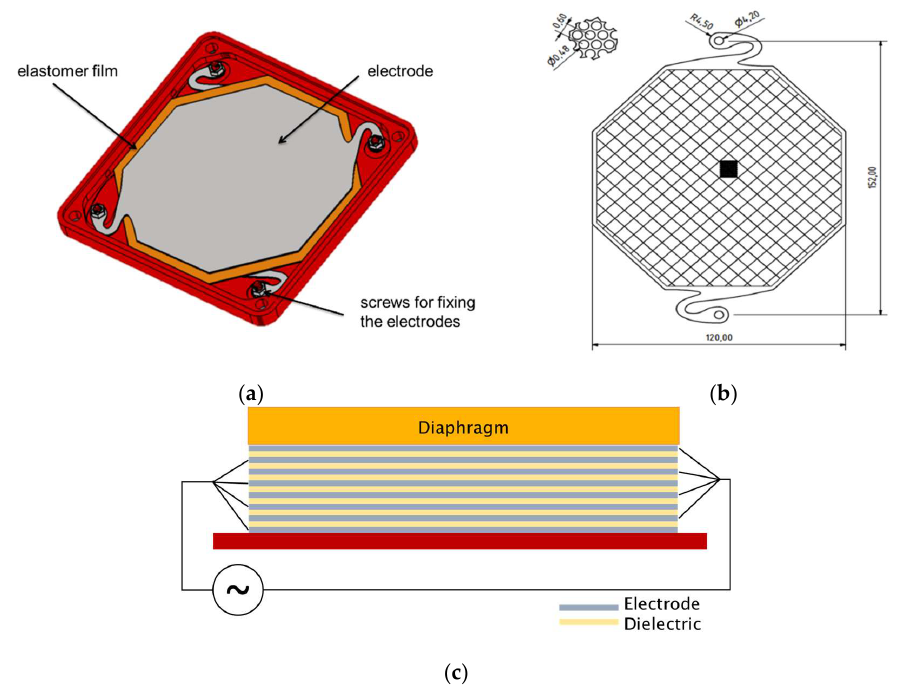
Figure 2. Prototype DEAP Loudspeaker: ( a ) CAD design; ( b ) electrode dimensions in mm; and ( c ) layering and connecting scheme.